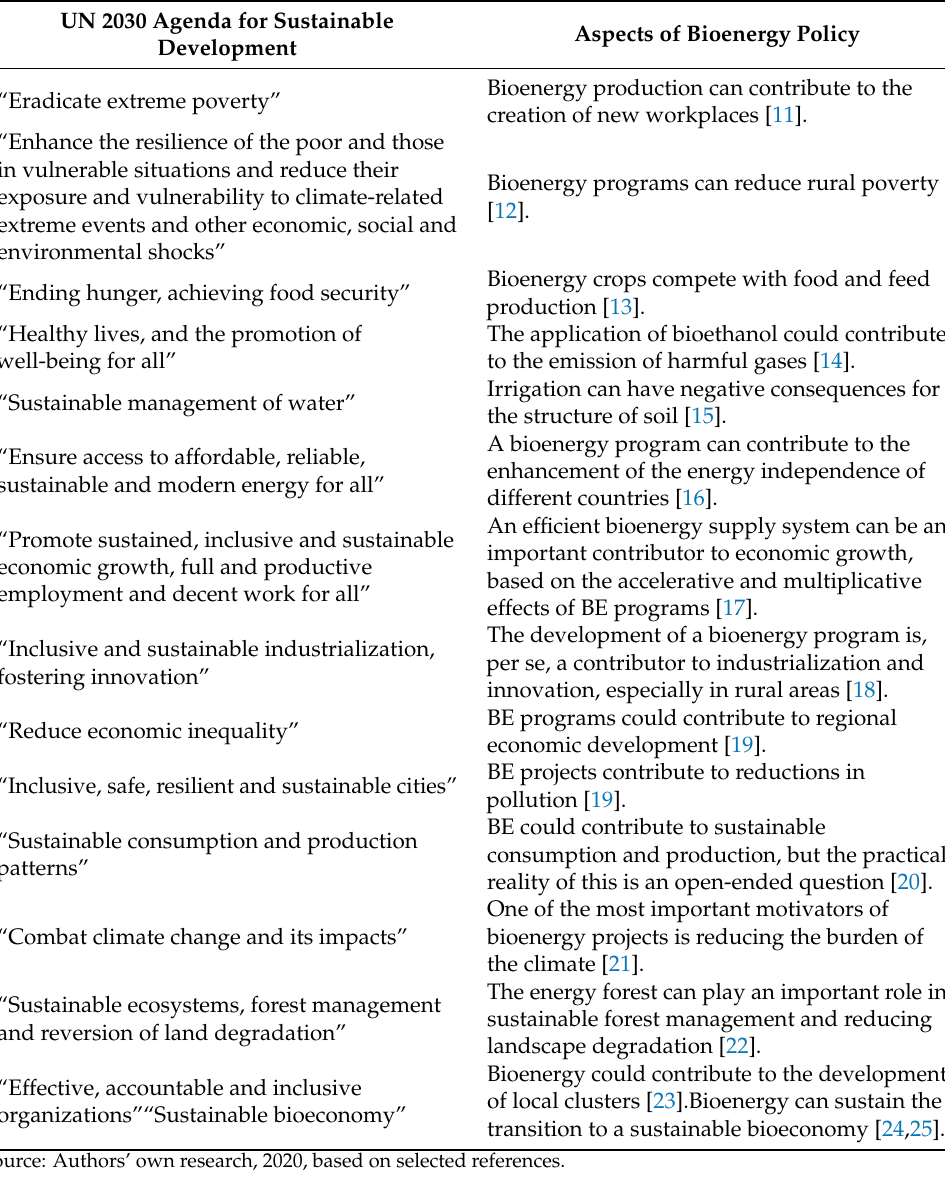
Table 1. The UN sustainable development goals and the question of bioenergy